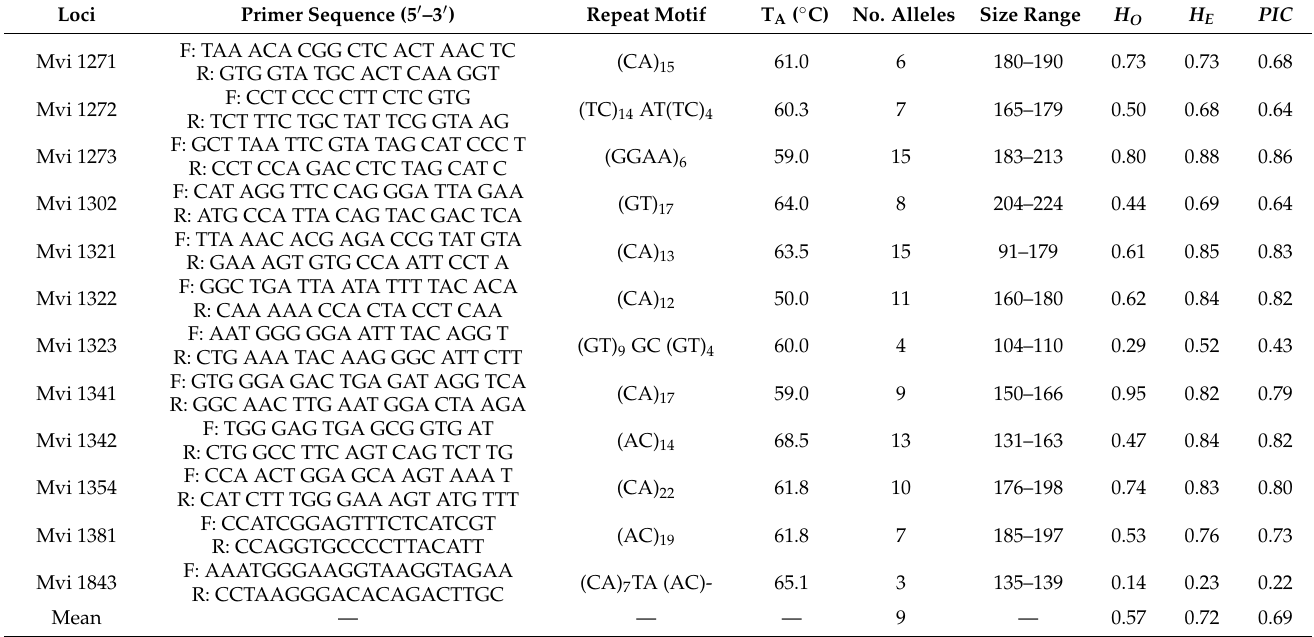
Table 1. Information on the 12 microsatellite loci used in this study. The loci name, primer sequence, repeat motif, annealing temperature (T A ), numbers of alleles, allele size range, observed ( H O ), expected ( H E ) heterozygosities, and average polymorphism information content ( PIC ) were included.